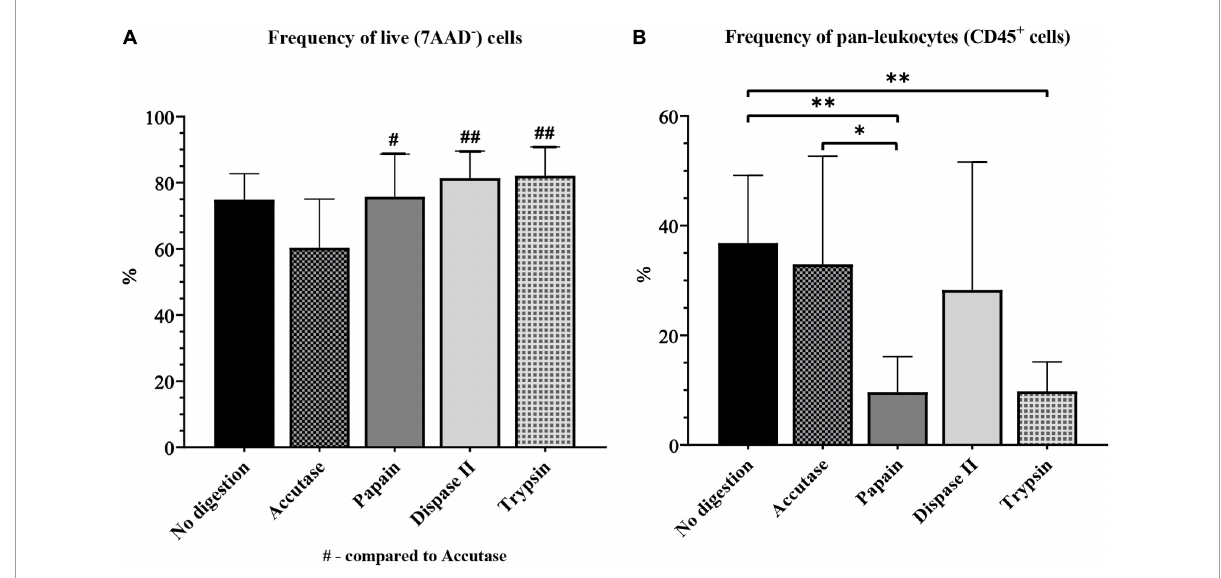
FIGURE7 The yield of live cells (A) and pan-leukocytes (B) on flow cytometry for different enzymatic digestion protocols. ∗ /# P < 0.05; ∗∗ /## P < 0.01. N (mice per group) =